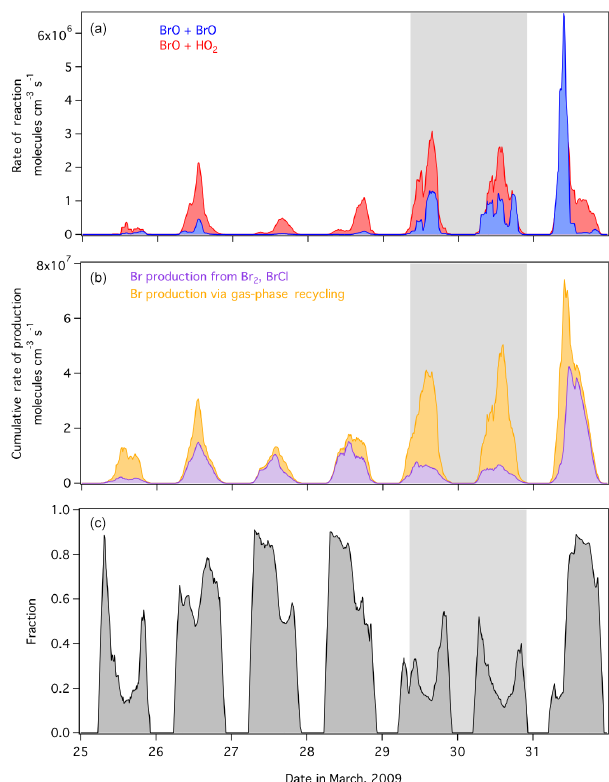
Figure 10. (a) Comparison of the rate of reaction of BrO + BrO (blue) and BrO + HO 2 (red). (b) The cumulative rate of Br atom production separated into the Br production rate from the photolysis of Br 2 and BrCl surface emissions calculated from Eq. (10) (purple) and the Br atom production rate due to gas-phase radical recycling calculated from Eq. (11) (orange). (c) The fraction of total Br atom production due to production from Br 2 and BrCl surface emissions. In all panels, model output is smoothed by hourly averaging. The grey-shaded box represents a period of missing Br 2 observations. Time is expressed in Alaska standard